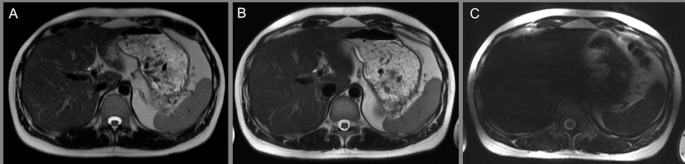
T2 TSE.T2 TSE imaging at 1.5 Tesla (A1,2) 3 Tesla (B1,2) and 7 Tesla (C1,2) in the same subject. Note equivalent image quality and contrast at 1.5 Tesla (A) and 3 Tesla (B). Despite the increased spatial resolution no improvement can be detected at 3 Tesla (B). Figure C shows strongly impaired T2 TSE imaging at 7 Tesla, revealing strong signal loss in parenchymatous organs. Hence, assessment of the biliary duct system was significantly hampered at 7 Tesla field strength (1.47Tesla, 4.93Tesla, 4.91.5Tesla). Quantitative evaluation confirmed limitations of T2w TSE at 7 Tesla showing lowest CR values for all analyzed organs compared to 3 Tesla and 1.5 Tesla, being significantly lower for the spleen tissue (CR7Tesla 0.29, CR3Tesla 0.67, CR1.5Tesla 0.63) with p<0.012, and non-significantly lower for liver and kidney tissue. Detailed graphs for evaluation of contrast ratios are displayed in Fig 2.